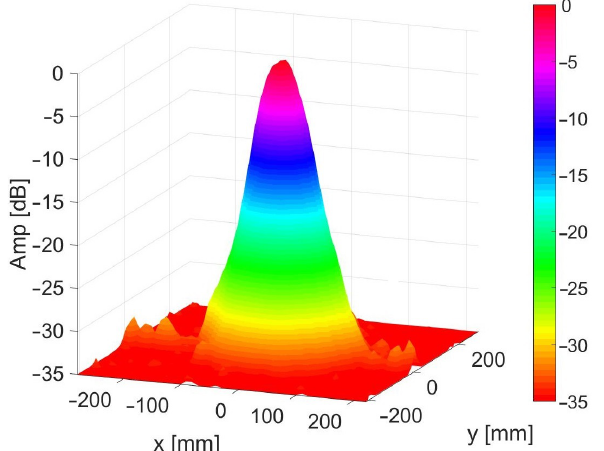
Figure 4. Plot of the measured array beam pattern (combining transmission and reception) for a 35 kHz sine wave using a 40 mm diameter reflector at 805 mm distance from the